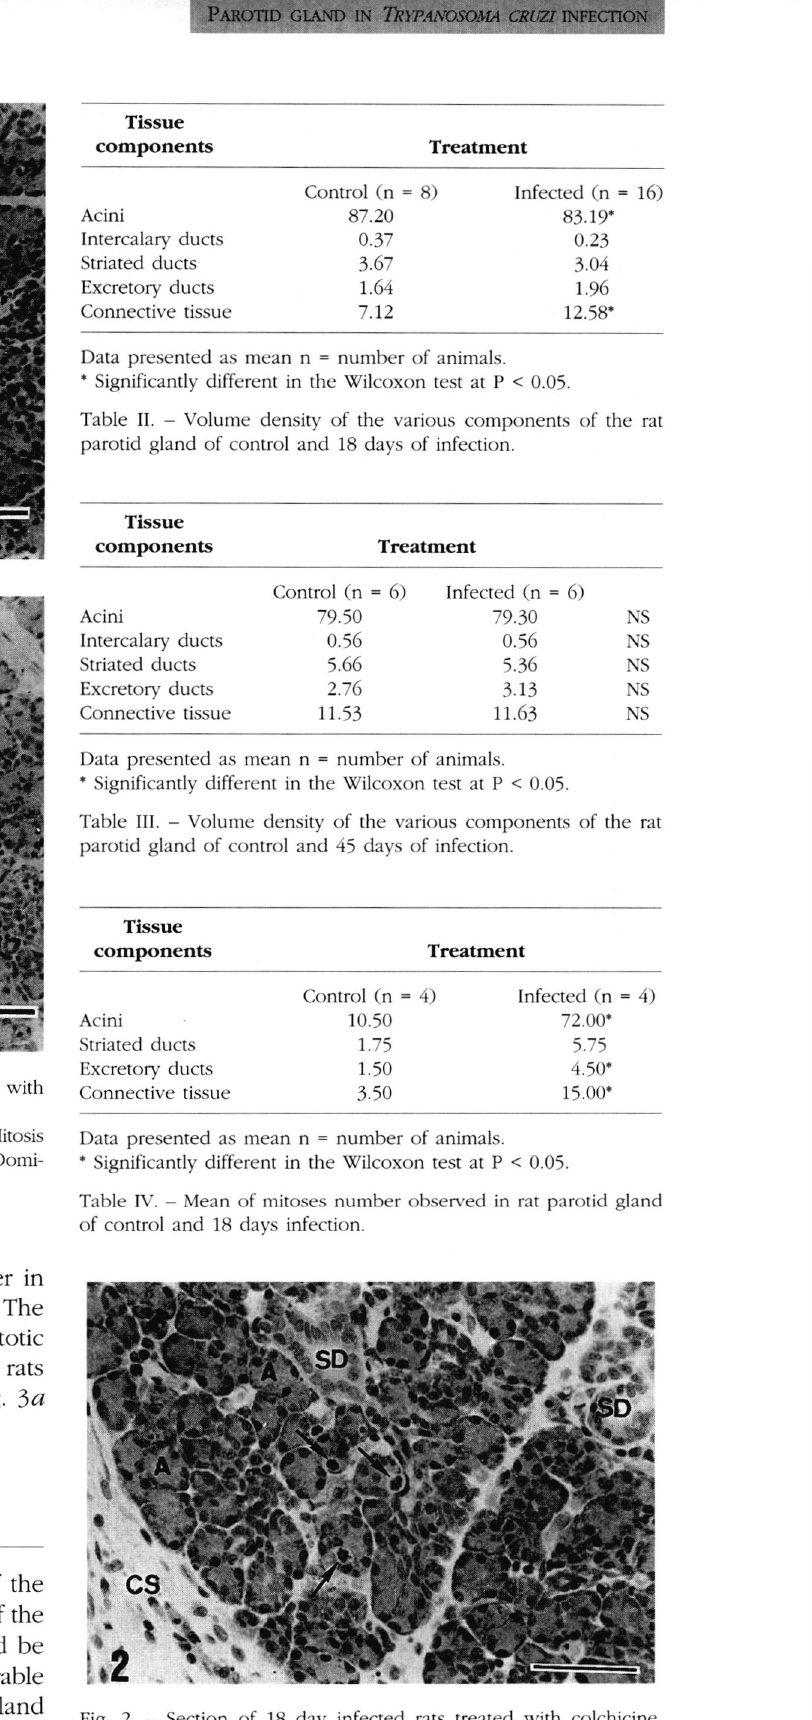
Fig. 2. - Section of 18 day infected rats treated with colchicine. Mitoses (arrows) were observed in acini, duct and connective tissue. Dominicci. Bar: 50